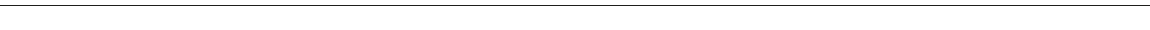
Fig. 6 Cisplatin induces K472 acetylation and S461 phosphorylation of PFKFB3. a DNA damage signals induced PFKFB3 K472 acetylation. Flag-tagged PFKFB3 was expressed in HEK293T cells, which were then treated with etoposide (10 μ M), adriamycin (1 μ M), UV irradiation (10 J/m 2 ) and cisplatin (50 or 100 μ M) for 24 h. Flag-PFKFB3 was immunoprecipitated with Flag beads and immunoblotting was performed with the antibodies indicated. Relative PFKFB3 K472 acetylation and phosphorylation were normalized by Flag protein. b The amino acid sequence near K472 of PFKFB3 displays high similarity with the sequence near K320 of TP53. c Cisplatin treatment induces PFKFB3 cytoplasmic accumulation. HEK293T cells were treated with or without cisplatin (50 μ M) for 24 h before harvest. Cells were then suspended in PBS and treated with a gradient concentration of digitonin. Supernatant and precipitate were collected for immunoblotting with indicated antibodies. S, supernatant; P, precipitate. d Cisplatin induces K472 acetylation and S461 phosphorylation of endogenous PFKFB3. Endogenous PFKFB3 protein was puri fi ed from HEK293T cells after cisplatin treatment as indicated for 24 h. e Cisplatin or etoposide treatment enhances K472 acetylation in SIRT1 knockout cells. Endogenous PFKFB3 protein were puri fi ed from WT or SIRT1 knockout HEK293T cells treated with EX527 (10 μ M), cisplatin (50 μ M) or etoposide (10 μ M) for 24 h. f Combined knockdown of PCAF and GCN5 abolishes cisplatin- or etoposide-induced PFKFB3 K472 acetylation. HEK293T cells were transfected with siRNAs targeting PCAF and GCN5. After 60 h, cells were treated with cisplatin (50 μ M) or etoposide (10 μ M) for 24 h. g , h Cisplatin treatment induces pan-acetylation of PCAF and GCN5. Flag-tagged PCAF or GCN5 was expressed in HEK293T cells, which were treated with cisplatin for the duration indicated at a concentration of 50 μ M. Relative pan-acetylation level of PCAF or GCN5 was normalized by Flag protein. i Cisplatin increases acetyltransferase activity of PCAF and GCN5. Flag-tag PCAF or GCN5 was puri fi ed from HEK293T cells treated with or without cisplatin (50 μ M) for 24 h, then incubated with recombinant His-PFKFB3 in acetylation assay buffer. Puri fi ed proteins visualized by Coomassie blue staining are shown (lower panel). Data are representative of at least two independent